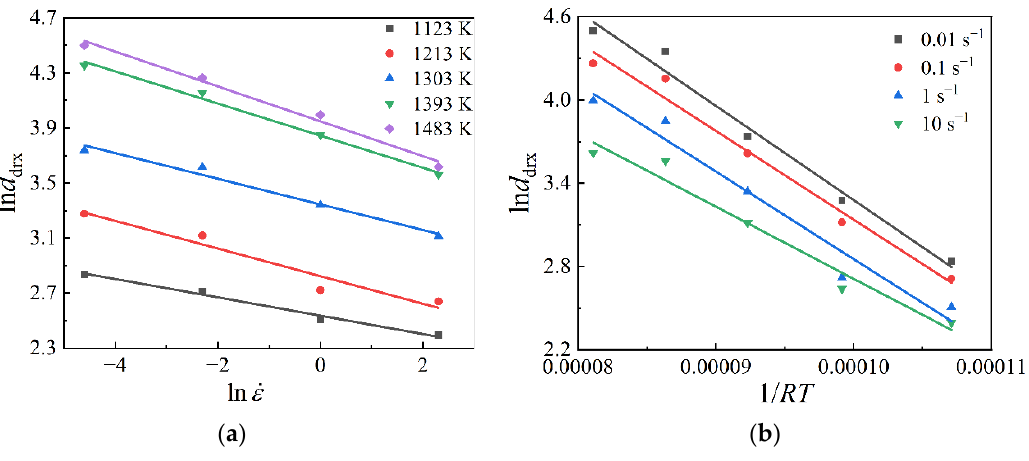
1 RT . Figure 13. Relationships of ( a ) ln d